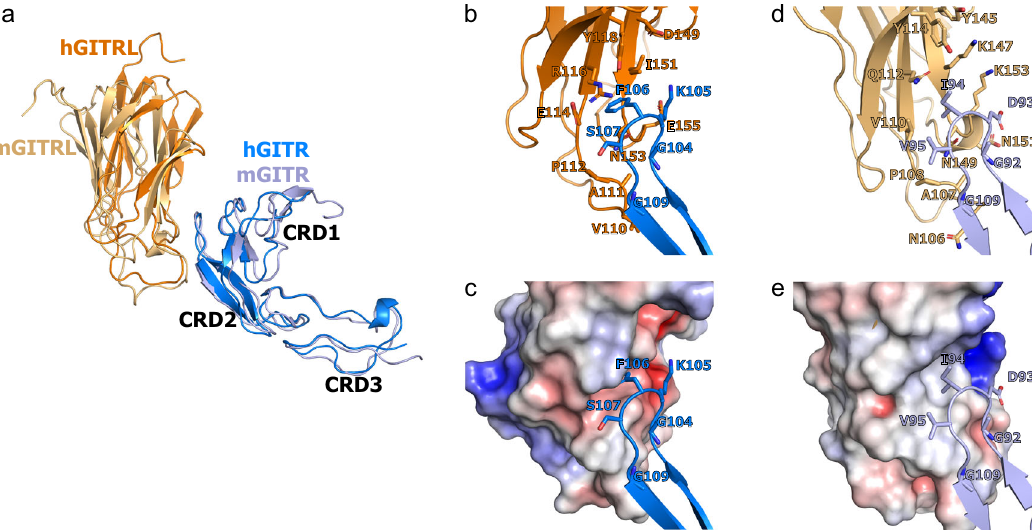
Fig. 2 Comparison of human and mouse GITR – GITRL interfaces. a Human and mouse GITR interact similarly with their cognate receptors (GITR shown in blue, GITRL in orange). Close view of 1:1 ligand – receptor interfaces are shown for human cartoon ( b ) and electrostatic surface ( c ) and mouse cartoon ( d ) and electrostatic surface ( e ). While having similar overall structure, the interfaces have low sequence conservation, with steric and electrostatic CRD2 is comprised of A2 and B1 modules, and its B1 module is hGITRL D149 and E155 that positively charged K105 is positioned the only portion of the receptor seen interacting with the ligand in near. mGITR does not have a buried phenylalanine, but rather an our structure (Fig. 2a). When examining interactions of the hGITR isoleucine, and the glycines are conserved (Fig. 2c). mGITRL has CRD2 binding interface (Fig. 2b), F106 makes the majority of the basic charges (K147 and K153), while mGITR has a negative charge buried interface, while G104 and G109 allow close contacts between (D93), but this electrostatic interaction does not appear as favorable the loop that extends from GITR to contact the membrane-distal as hGITR. Generally, the small interface (~400 Å 2 ) lacks conserved complementary charges or extensive hydrophobic packing (Fig. S3). portion of GITRL. There is a cavity of negative potential from